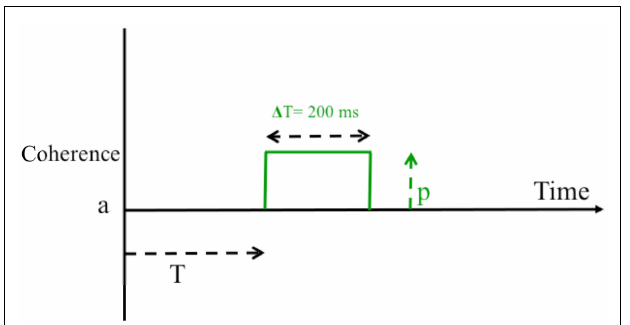
FIGUREA1 | Illustration of perturbation protocol in Experiment 1B. After T ms the motion coherence level changes from a to a + p for a duration of 200ms.